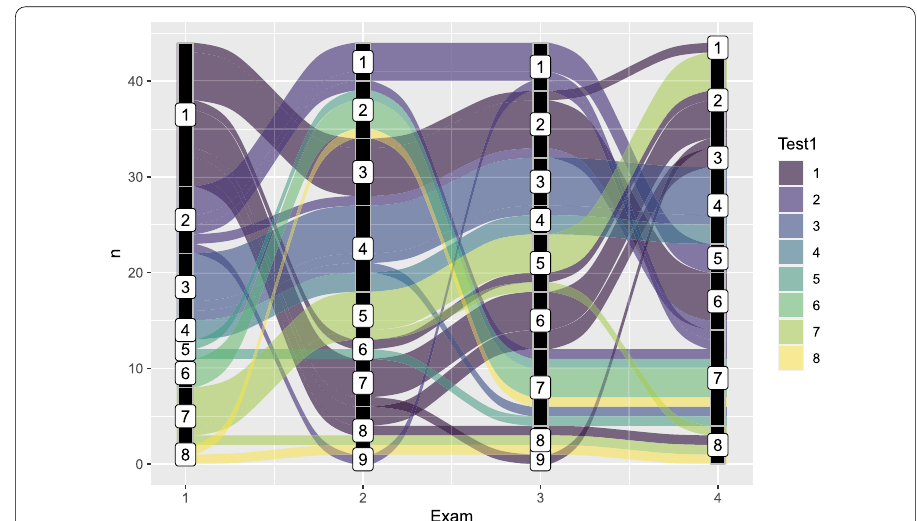
Fig. 12 Fall 2015 CONCOR block membership by exam. Traces are colored by students’ exam 1 block